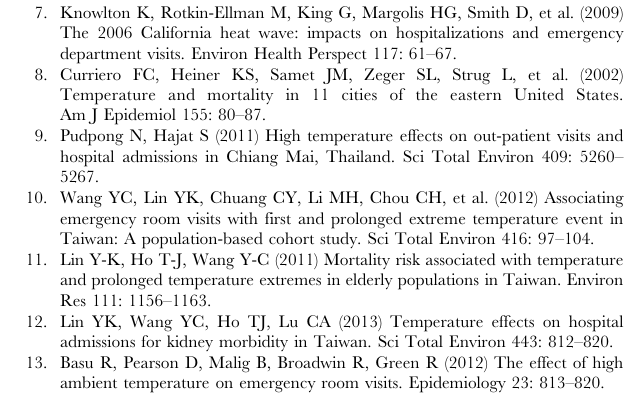
Figure S1 Associations between emergency room visits for cerebrovascular diseases, heart diseases, and ische- mic heart diseases and daily average temperature in metropolitan Taipei from 2000 to 2009. Top row: Cumulative 8-day (lag 0 to lag 7) RRs for cerebrovascular diseases, heart diseases, and ischemic heart diseases (IHD) estimated using DLNM and a centered temperature of 26 u . Middle and bottom rows: RR of ERV for cerebrovascular diseases, heart diseases, and IHD associated with an ambient temperature of 14 u C (middle row) or 32 u C (bottom row) compared to a centered temperature of 26 u C on lag 0 to lag 7.